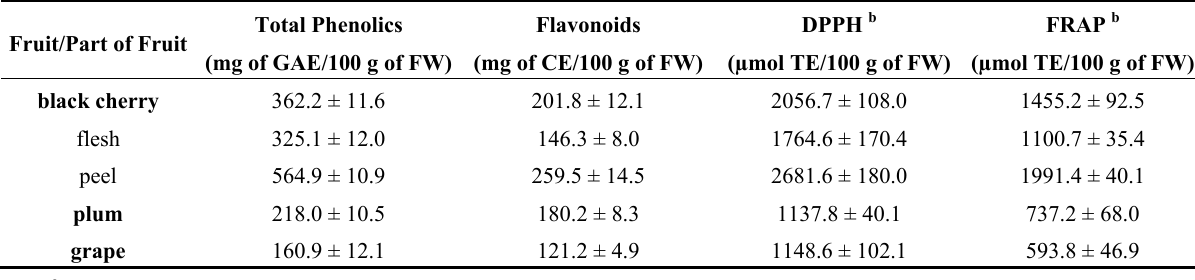
Table 3. Total Phenolics, Flavonoids, and Antioxidant Capacity (DPPH and FRAP) in Black Cherry Fruit, Plum, and Grape a